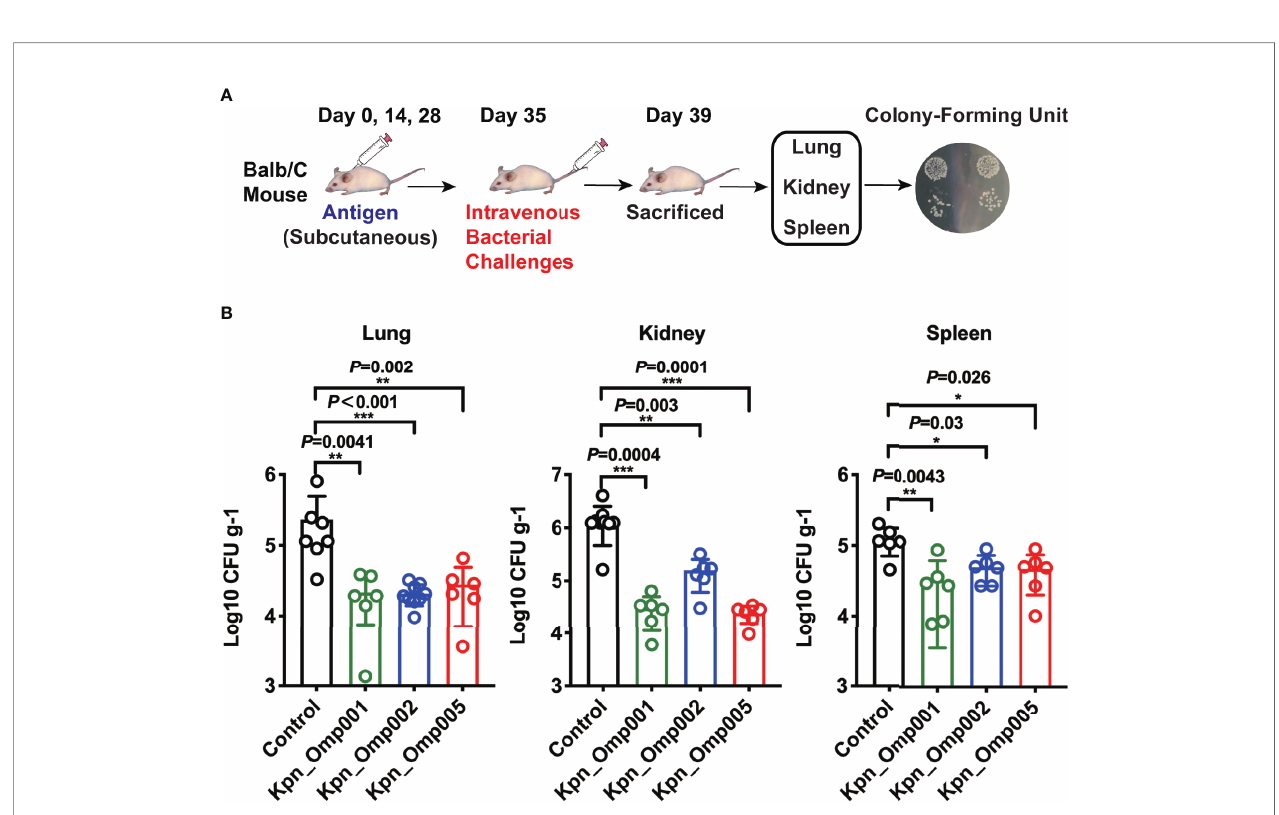
FIGURE 5 | Bacterial load assay. (A, B) Balb/c mice were immunized with the Kpn_Omp001, Kpn_Omp002, and Kpn_Omp005 individually or PBS, and they were injected with 5 × 10 8 CFU of K pneumoniae 260 in 7 days after the second booster vaccination. The lungs, kidneys, and spleens were collected 4 days after the sub-lethal challenge and homogenized. CFUs were enumerated following serial diluting and plating on BHI agar. *p < 0.05, **p < 0.01, ***p <